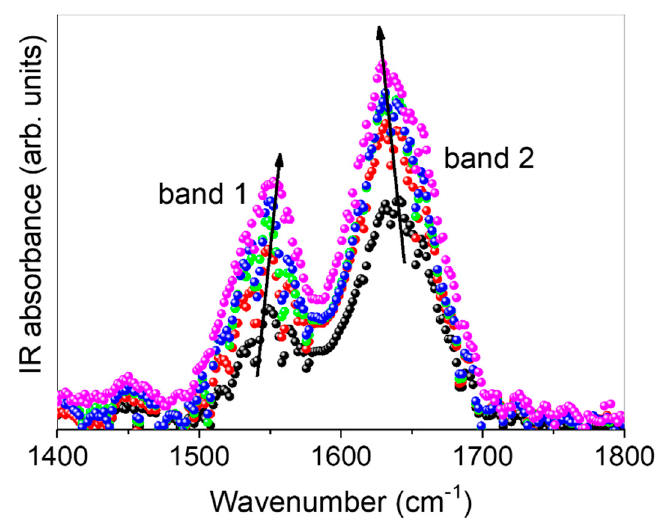
Figure 8. Experimental FT-IR spectra for untreated excised bovine nasal mucosa (black circles), and for the mucosae treated for 24 h with free IDE (red circles), IDE/HP- β -CD inclusion complex (pink circles), the non-overloaded (green circles), and overloaded CS NPs (blue circles). Arrows are guides for the eyes. See text for details.